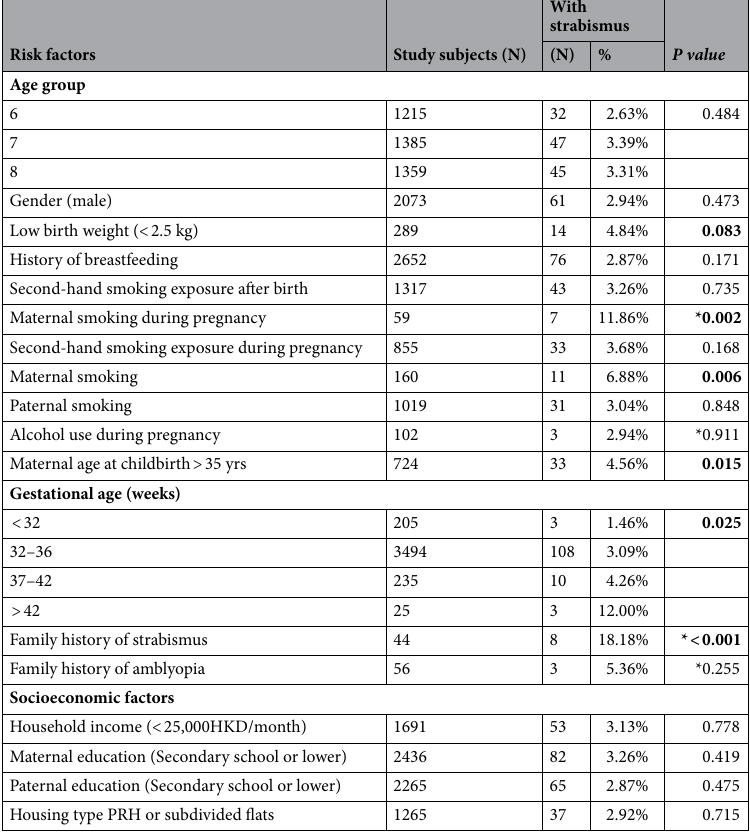
Table 4. Univariate analysis for risk factors associated with strabismus in Hong Kong children. *Fisher exact test.